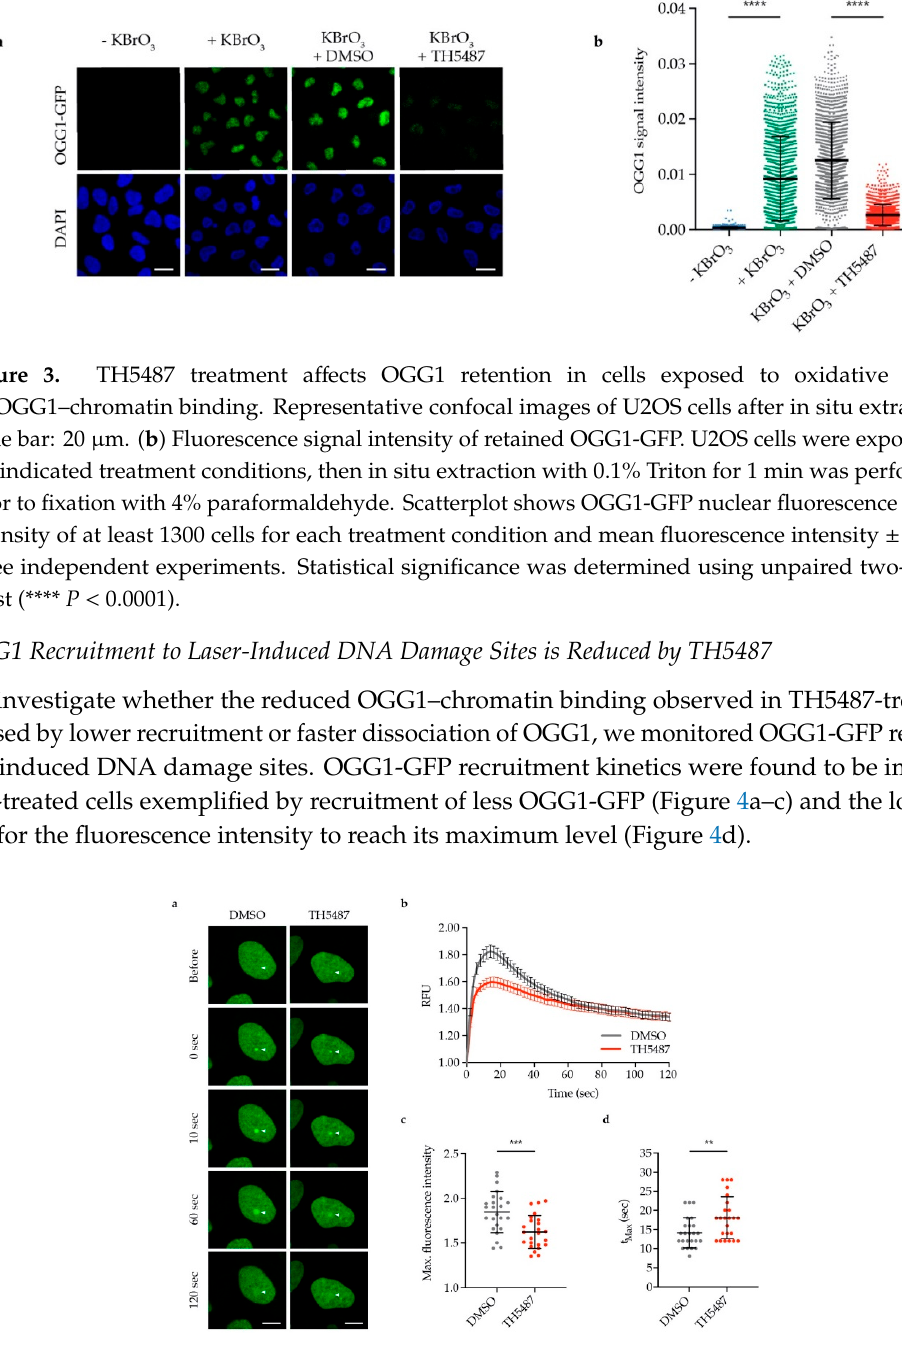
Figure 4. TH5487 treatment reduces OGG1 recruitment to laser-induced DNA damage sites. ( a ) Representative images of DMSO- and TH5487-treated U2OS cells expressing OGG1-GFP. Arrows indicate the point of laser irradiation. Scale bar: 10 μ m. ( b ) OGG1 recruitment kinetics. U2OS cells expressing OGG1-GFP were pre-sensitized with Hoechst and treated with either 0.1% DMSO or 10 μ M TH5487 for 1 h, then DNA damage was induced with a 405 nm laser. RFU (relative fluorescence units). ( c ) Quantification of the maximum fluorescence intensity upon OGG1-GFP recruitment. ( d ) Quantification of the time needed to reach maximum fluorescence of OGG1-GFP. The scatterplots show the data of at least 24 cells for each treatment condition. Data are means ± SEM (b) or means ± SD (c,d) of two independent experiments. Statistical significance was determined using unpaired two-sided t -tests (** P < 0.01, *** P < 0.001).